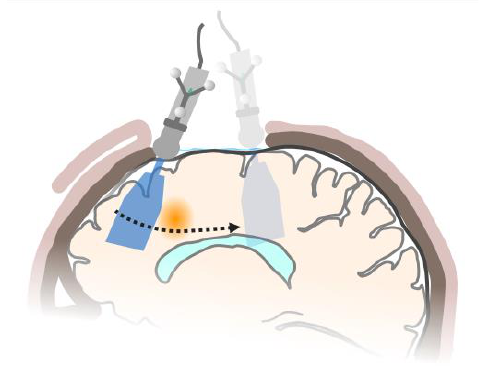
Figure A1. Acquisition of i3D US. The navigated US probe is swiped over the dural layer. The reference array on the probe and the head clamp must be in the sight of line of the navigational camera. 2D slices of 0.3 mm are generated and transformed to a 3D data set.